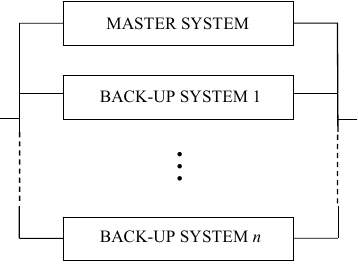
Figure 3. Reliability structure scheme of navigation system with n back-up systems.